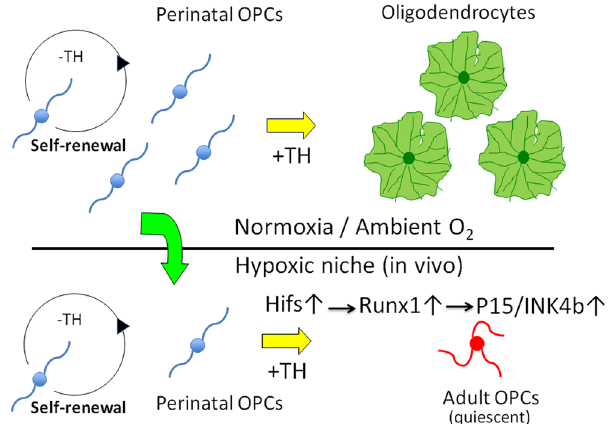
Figure 9. A schematic diagram of perinatal to adult transition of OPCs. In developing rat optic nerves, thyroid hormone inhibits the proliferation of perinatal OPCs. In normoxia, cells differentiate into oligodendrocytes. On the other hand, in a hypoxic niche, quiescent OPCs sustain their potential capacities of proliferation and differentiation as adult somatic stem cells (Adult OPCs). Hypoxia-inducible factors-mediated Runx1 expression and resultant p15/INK4b induction contributes to development of adult